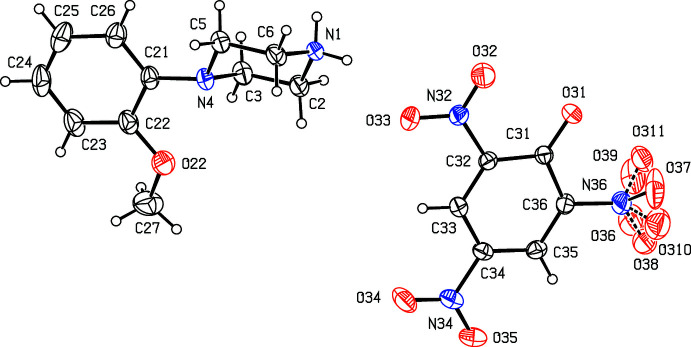
The independent components of compound (XII) showing the atom-labelling scheme and the disorder in one of the nitro groups, where the dominant disorder component is drawn using full lines, and the two minor disorder components are drawn using broken lines. Displacement ellipsoids are drawn at the 30% probability level.